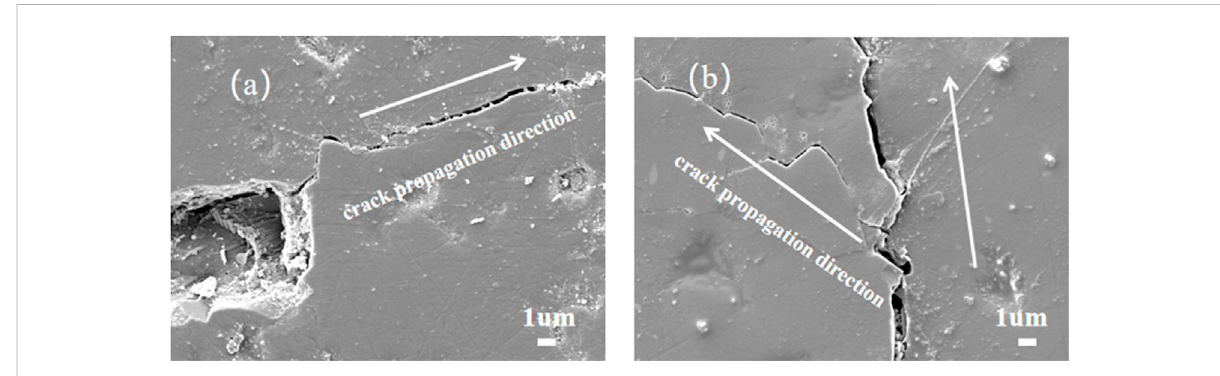
FIGURE 5 SEM images of crack propagation path of (A) Al 2 O 3 and (B) Al 2 O 3 -1.0 wt% graphene